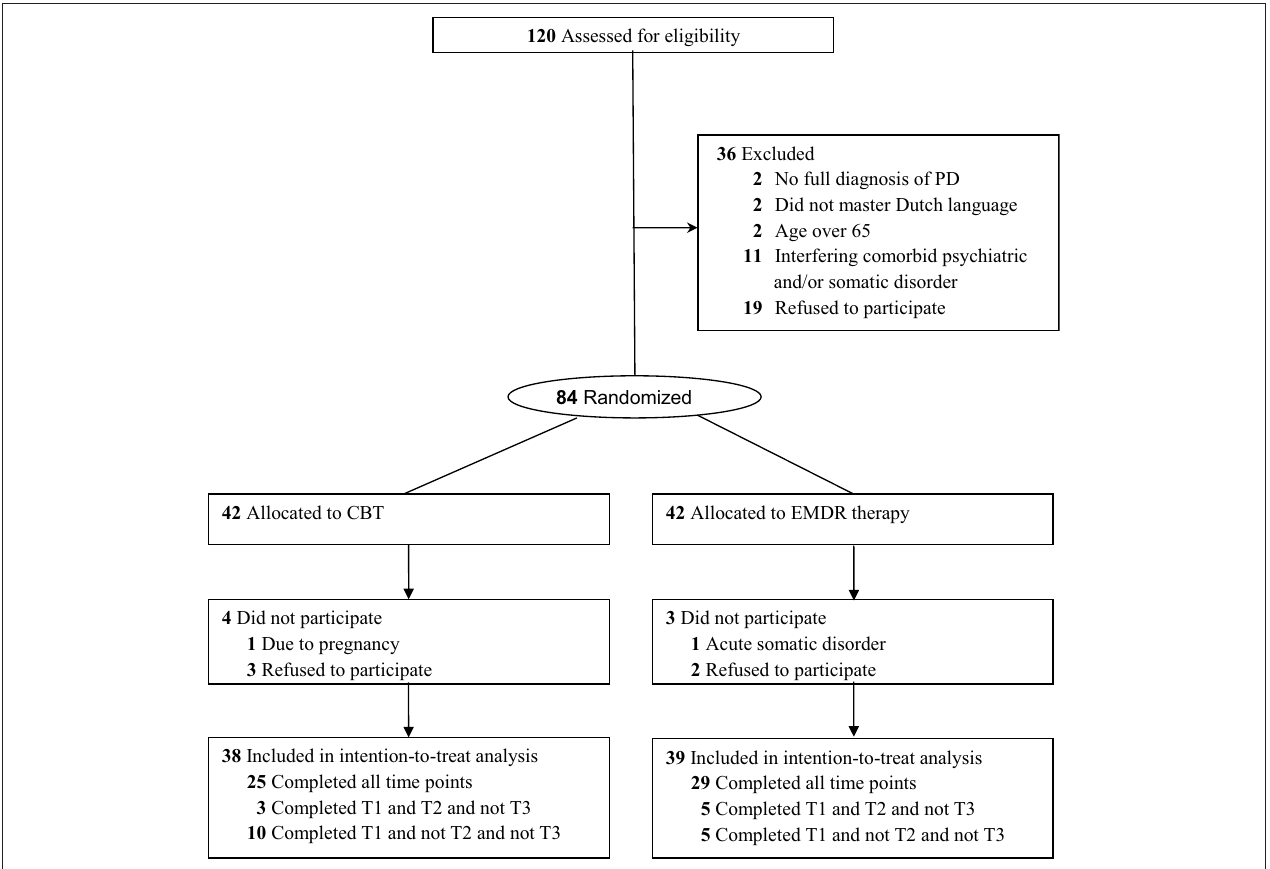
FIGURE 1 | Flow of participants through the